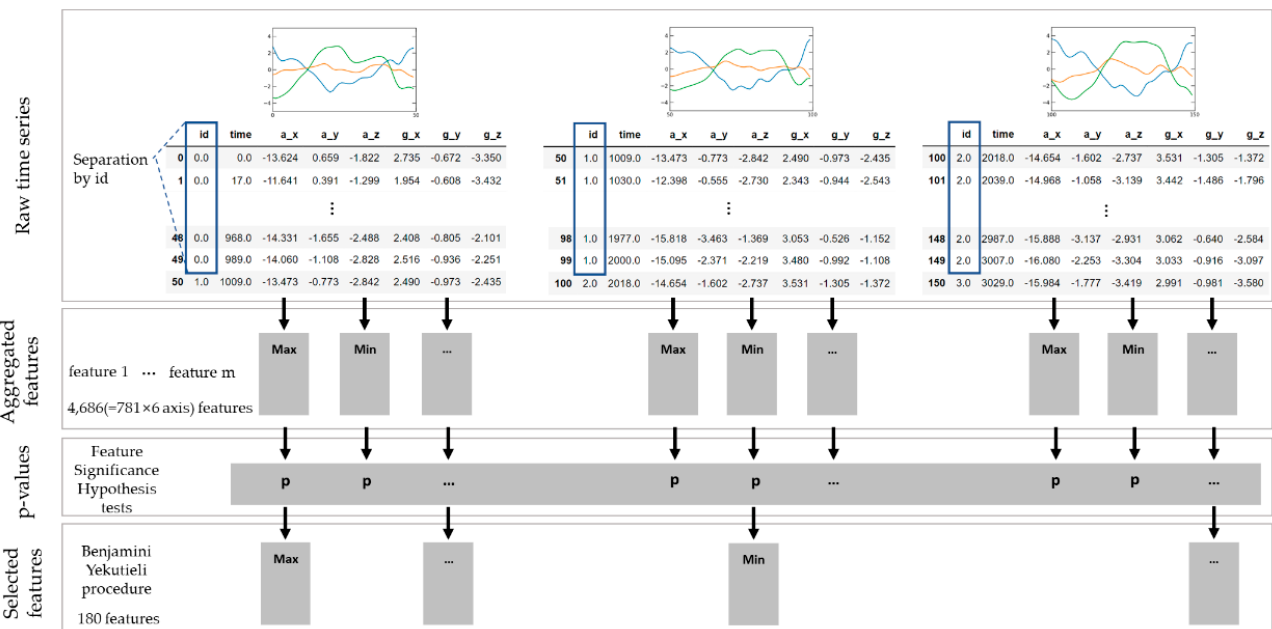
Figure 5. Workflow of feature filtering process. A set of features was extracted from the partitioned MTS data and then selected according to a statistical significant test [54].